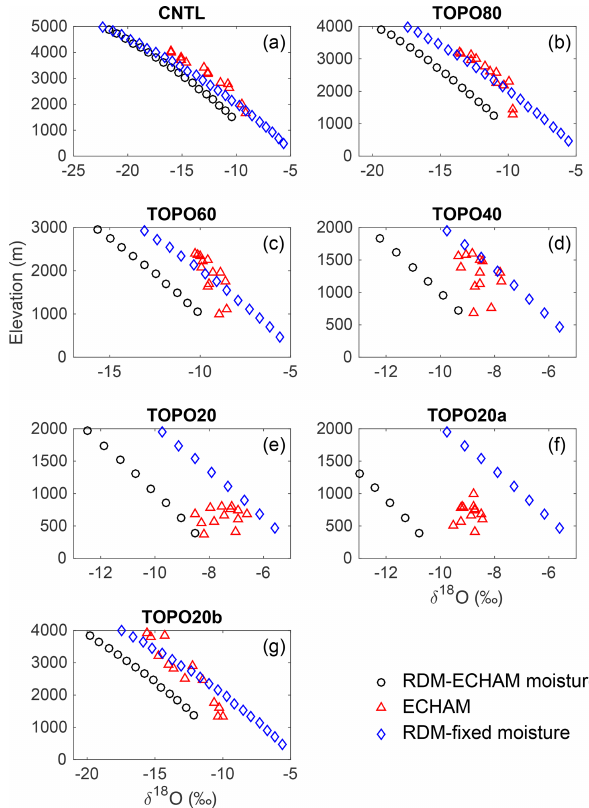
Figure 9. Same as in Fig. 7 but for the East Asian summer mon- soon (EASM) region of the southern Himalayan